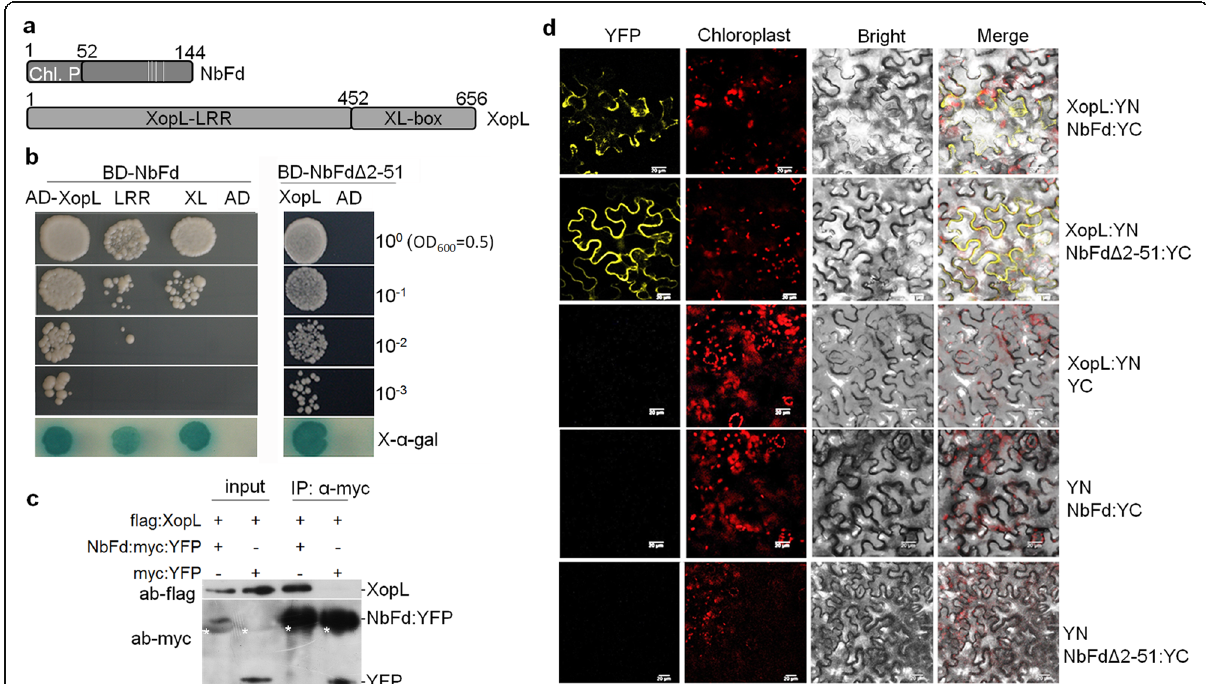
Fig. 3 Nb ferredoxin (NbFd) interacts with XopL. a Schematic representation of relevant domains in NbFd and XopL. Chl. P, chloroplast addressing peptide; XopL-LRR, XopL-leucine rich-repeat domain; XL-box, E3 ligase domain containing the XL-box. Numbers above functional maps denote the position of the domains with respect to the start codon. b Yeast two-hybrid assay showing interactions between NbFd and XopL and variants on SD/ − Leu-Trp-His-Ade agar medium with and without 20 mg/mL X- α -GAL. Experiments were repeated three times. c CoIP analysis of 3 × flag-XopL and NbFd-YFP in vivo. Leaf extracts were incubated with anti-myc labeled magnetic beads. Samples before (input) and after (IP: α -myc) immunopurification were analyzed by immunoblotting using anti-flag and anti-myc antibodies. White asterisks indicate non- specific reactions with c-myc antisera. Representative picture of three replicates were shown. d BiFC visualization of the interaction between YN- tagged XopL and YC-tagged ferredoxin in Nb leaves. Controls included XopL:YN coinfiltrated with empty YC vector and empty YN vector coinfiltrated with NbFd:YC (NbFd:YC). Chloroplasts were visualized by auto-fluorescence. Bars represent 20 μ m. Experiments were performed